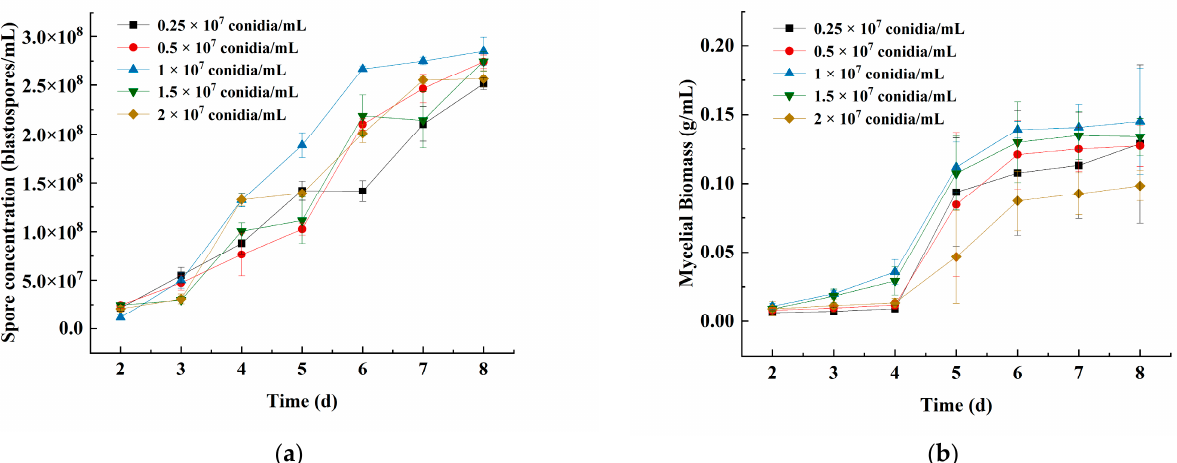
Figure 3. Effects of different primary inoculum density on the ( a ) spore concentration and ( b ) mycelial biomass of strain JMF-01. The data in the figure are the mean ± SEM. The SEM of three repetitions is shown in bars.